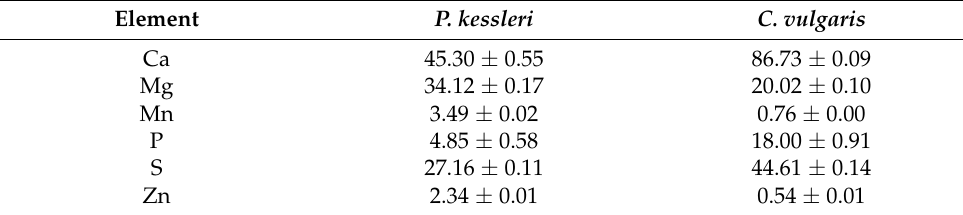
Table 3. Elemental composition of P. kessleri and C. vulgaris EPS ( µ g/mg) ( ± SD; n = 3).